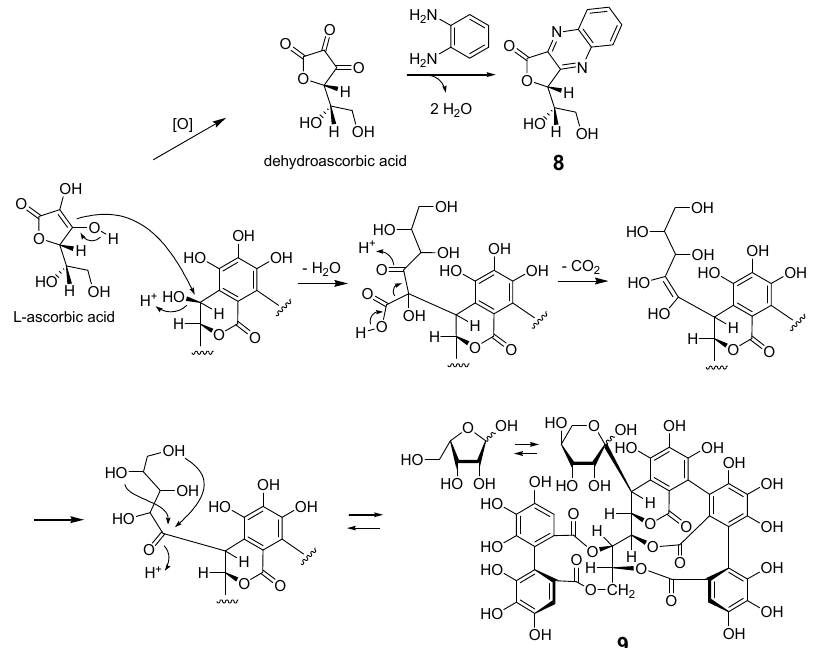
Scheme 2. Mechanism of formation of 8 and participation of ascorbic acid in the biosynthesis of grandinin ( 9 ).